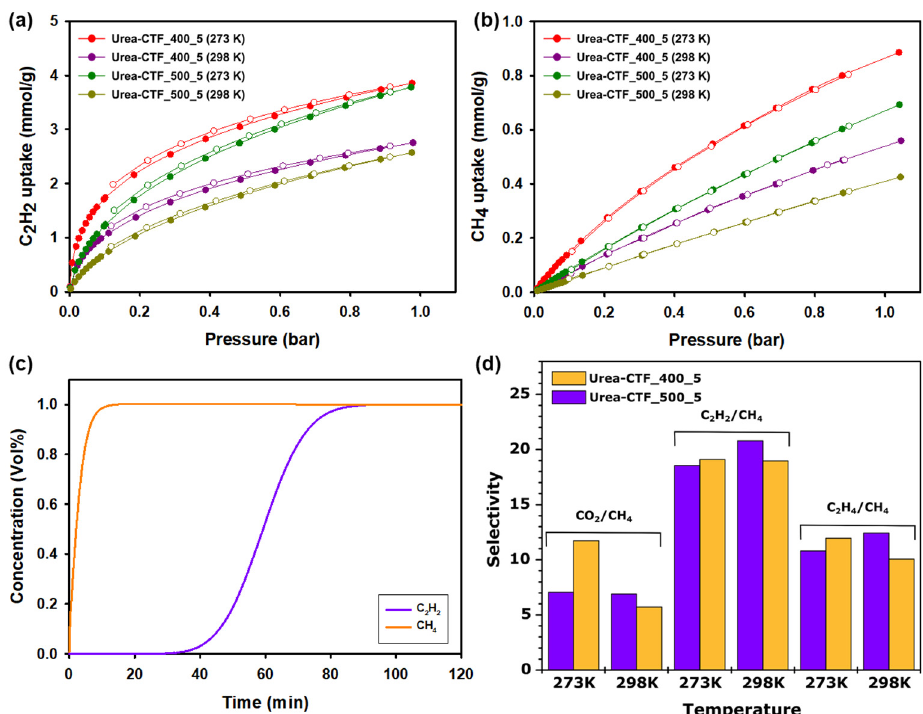
Figure 2. ( a ) C 2 H 2 uptake, ( b ) CH 4 uptake, ( c ) C 2 H 4 /CH 4 breakthrough simulation of urea-CTF_400_5, and ( d ) CO 2 , C 2 H 2 , and C 2 H 4 selectivities over CH 4 of urea-CTF_400_5 and